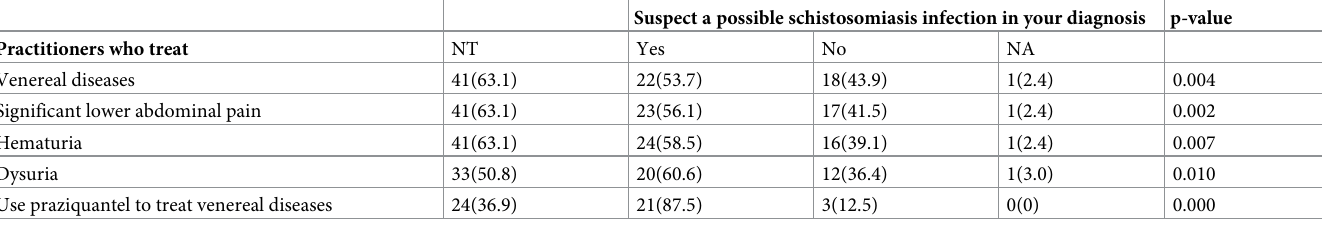
Table 3. Prevalence of schistosomiasis suspicion among practitioners during routine practice. Suspect a possible schistosomiasis infection in your diagnosis